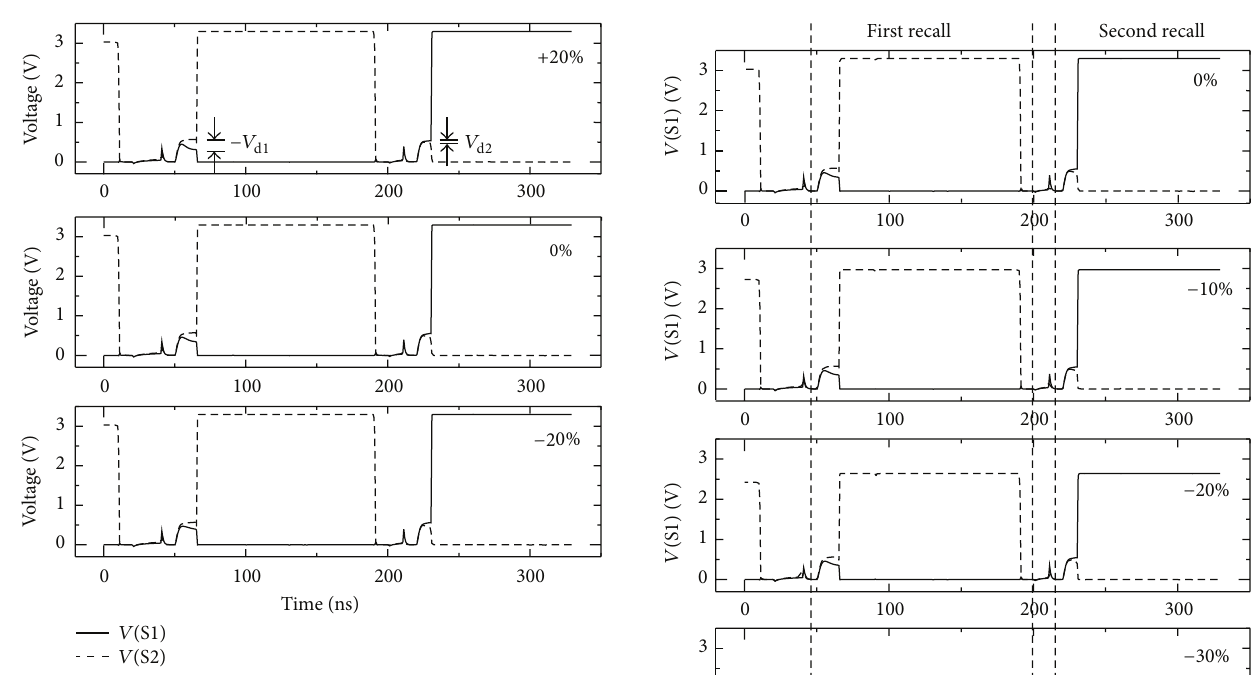
the 𝑉 increases slightly (90 mV (0%) → 115 mV ( − d2